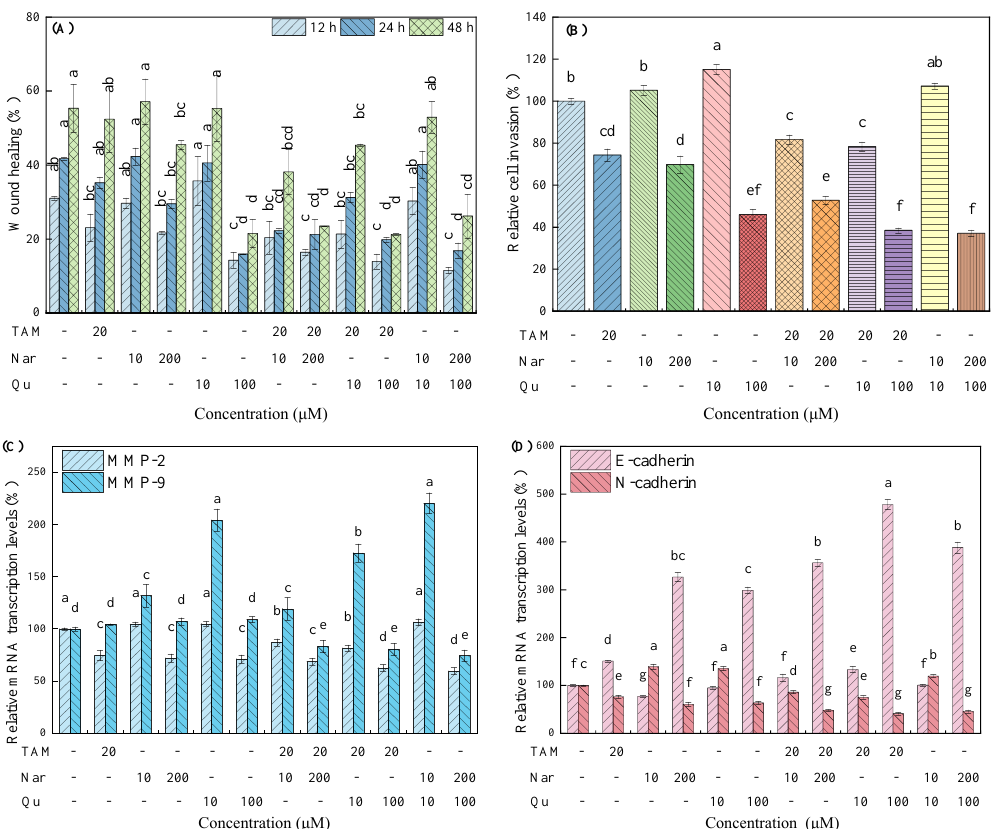
Figure 3. Effects of tamoxifen, naringenin and quercetin on cell migration and invasion in HepG2 cells. ( A ) Scratch healing following treatment with tamoxifen (20 µ M), naringenin (10 and 200 µ M) and quercetin (10 and 100 µ M) alone or in combination for 12, 24 and 48 h. ( B ) Relative cell invasion ratio following treatment with tamoxifen, naringenin and quercetin for 24 h. ( C , D ) Tamoxifen, naringenin and quercetin regulated the gene expression of MMP-2, MMP-9, E-cadherin and N-cadherin in the mRNA transcription levels. Results are expressed as mean ± SD of three independent experiments ( n = 3). a–g : Different letters indicate significant differences ( p < 0.05) in cell migration and invasion, as well as their related